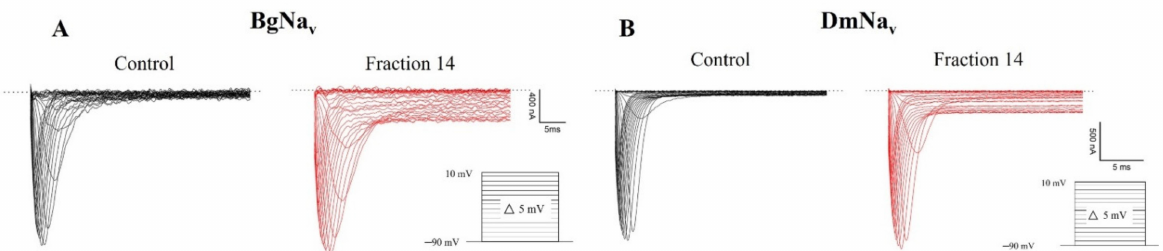
Figure 11. The effects on the insect BgNa v and DmNa v channels induced by fraction 14 on currents of the cloned insect BgNa v channels ( A ) and DmNa v channels ( B ), expressed in Xenopus oocytes. Current traces were elicited by 5 mV step depolarizations in control (black) and the presence of 0.4 µ g/ µ L fraction 14 (red). The dotted line indicates zero current